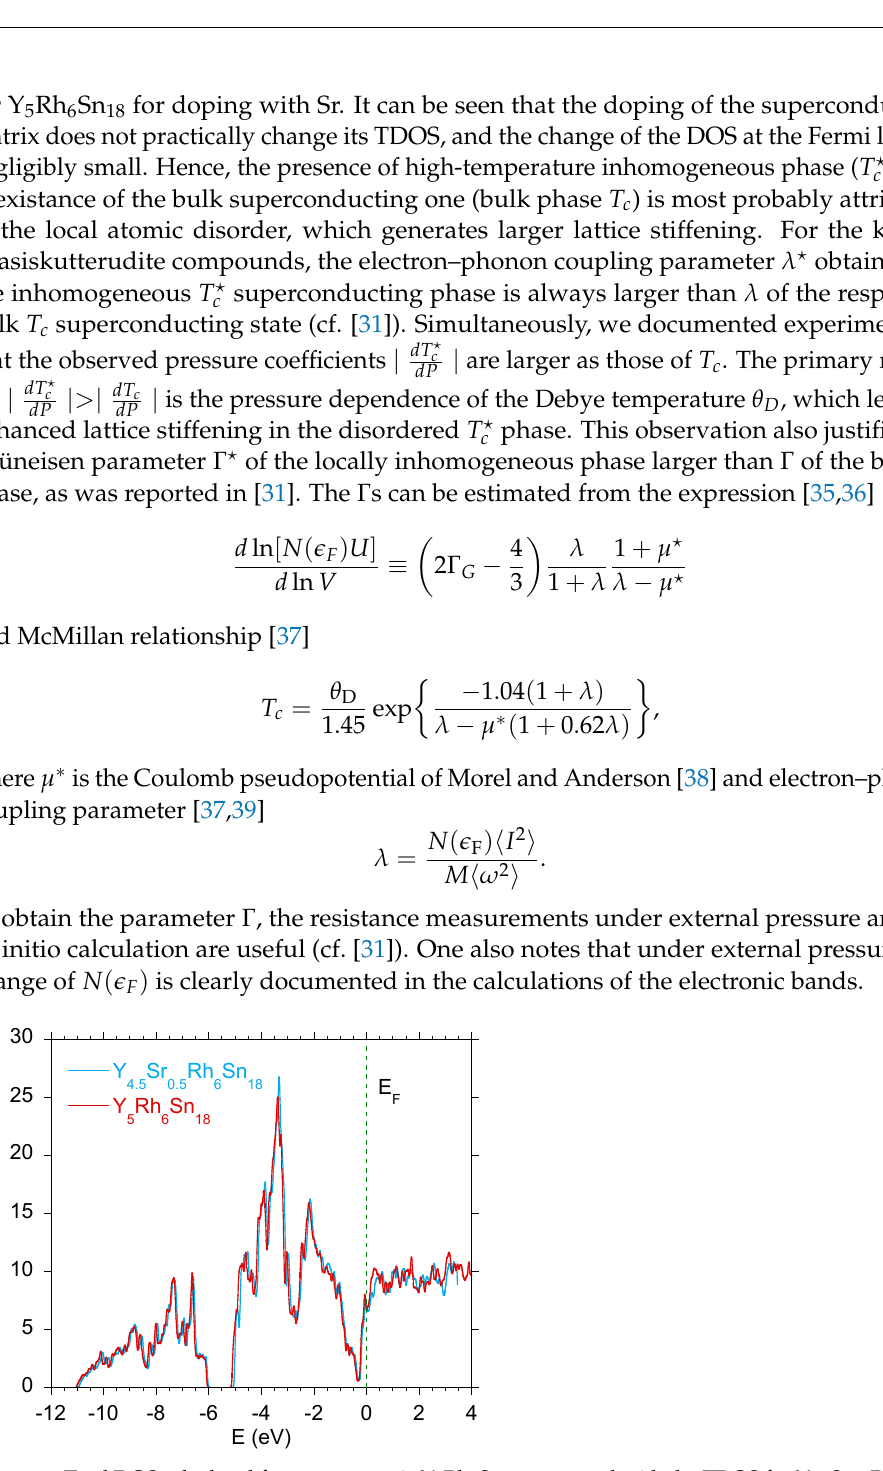
Figure 5. Total DOS calculated for paramagnetic Y 5 Rh 6 Sn 18 compared with the TDOS for Y 4.5 Sr 0.5 Rh 6 Sn 18